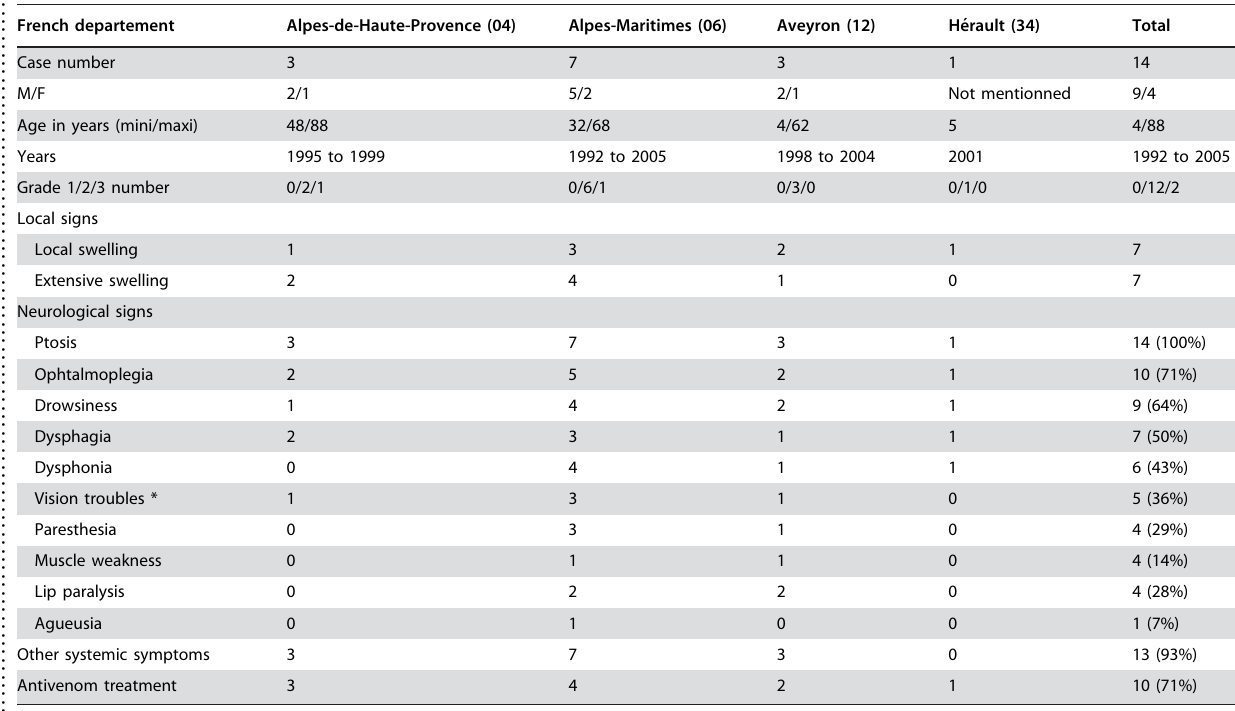
Table 1. Clinical cases of neurotoxic envenomations .. ... .... ... ... .... ... ... .... ... ... .... ... ... .... ... ... .... ... ... .... ... ... .... ... ... .... ... ... .... ... ... .... ... ... .... ... ... .... ... ... .... ... ...